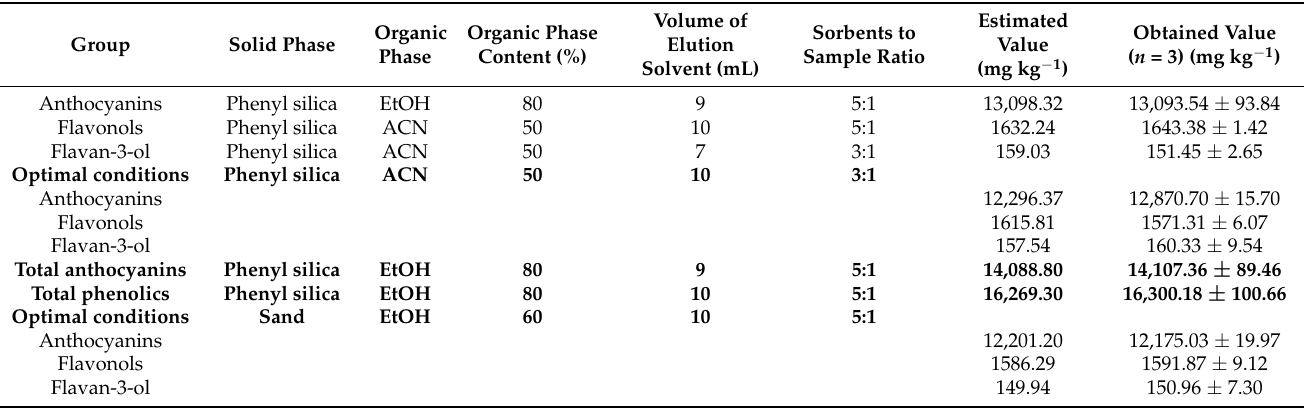
Table 8. Optimal conditions of the MSPD-predicted and experimentally obtained values for individ- ual groups of